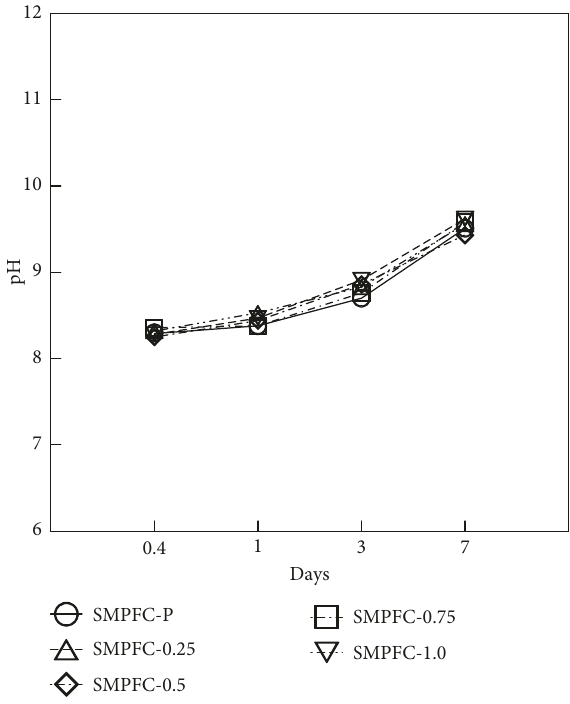
Figure 7: pH measurement results of